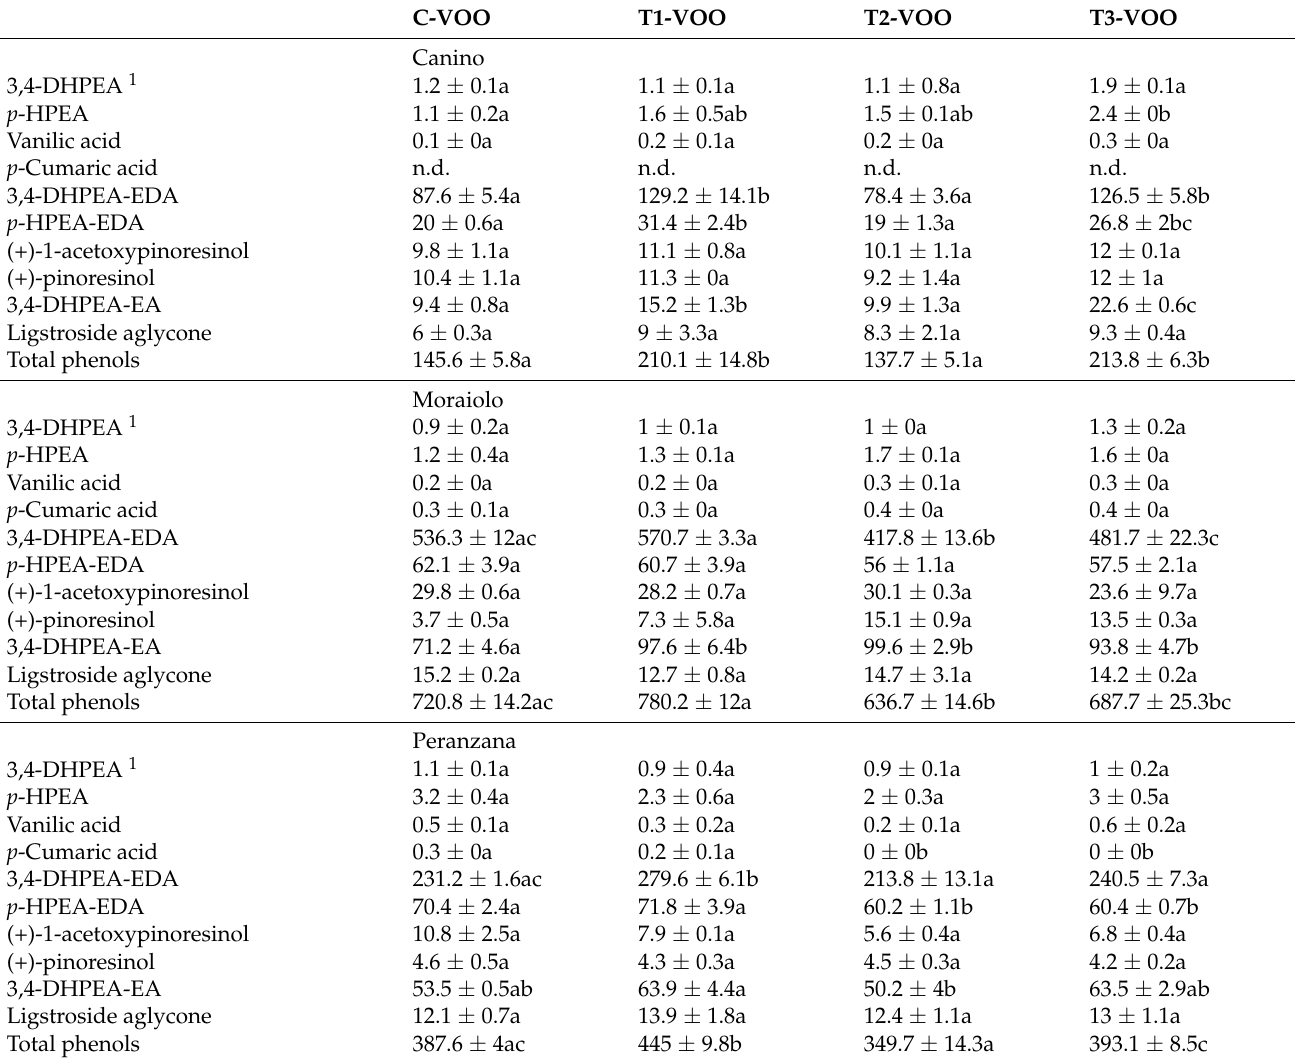
Table 2. Phenolic composition (mg/kg) of VOOs extracted at different processing